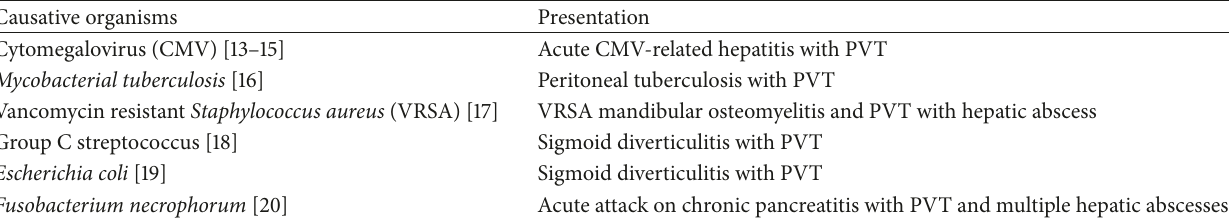
Table 1: List of causative organisms that have been reported as causing portal vein thrombosis